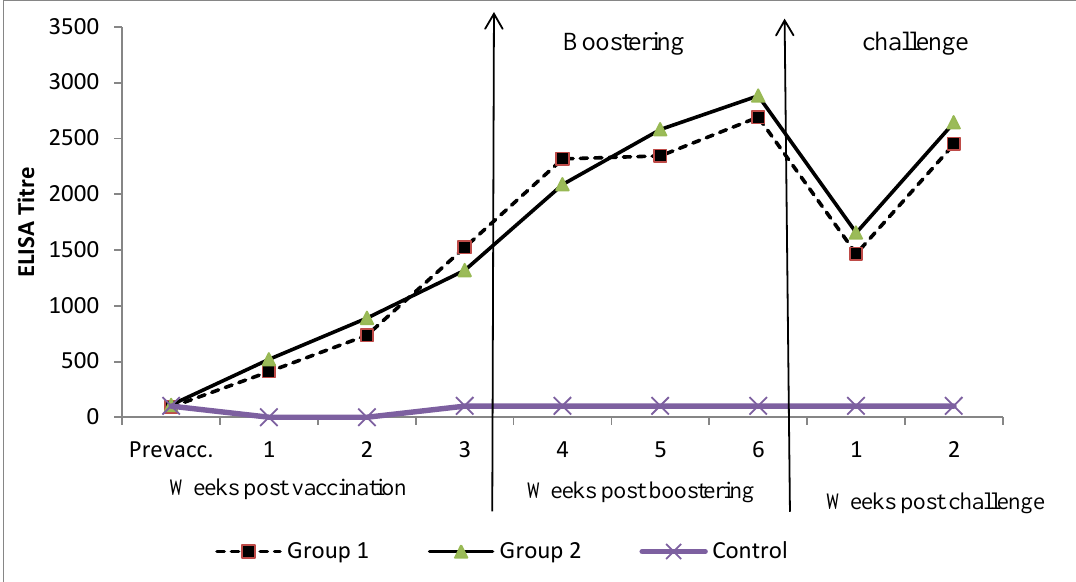
Fig.4: ELISA titer in sera of vaccinated turkey poults using O78 antigen and challenged with E.coli serotype